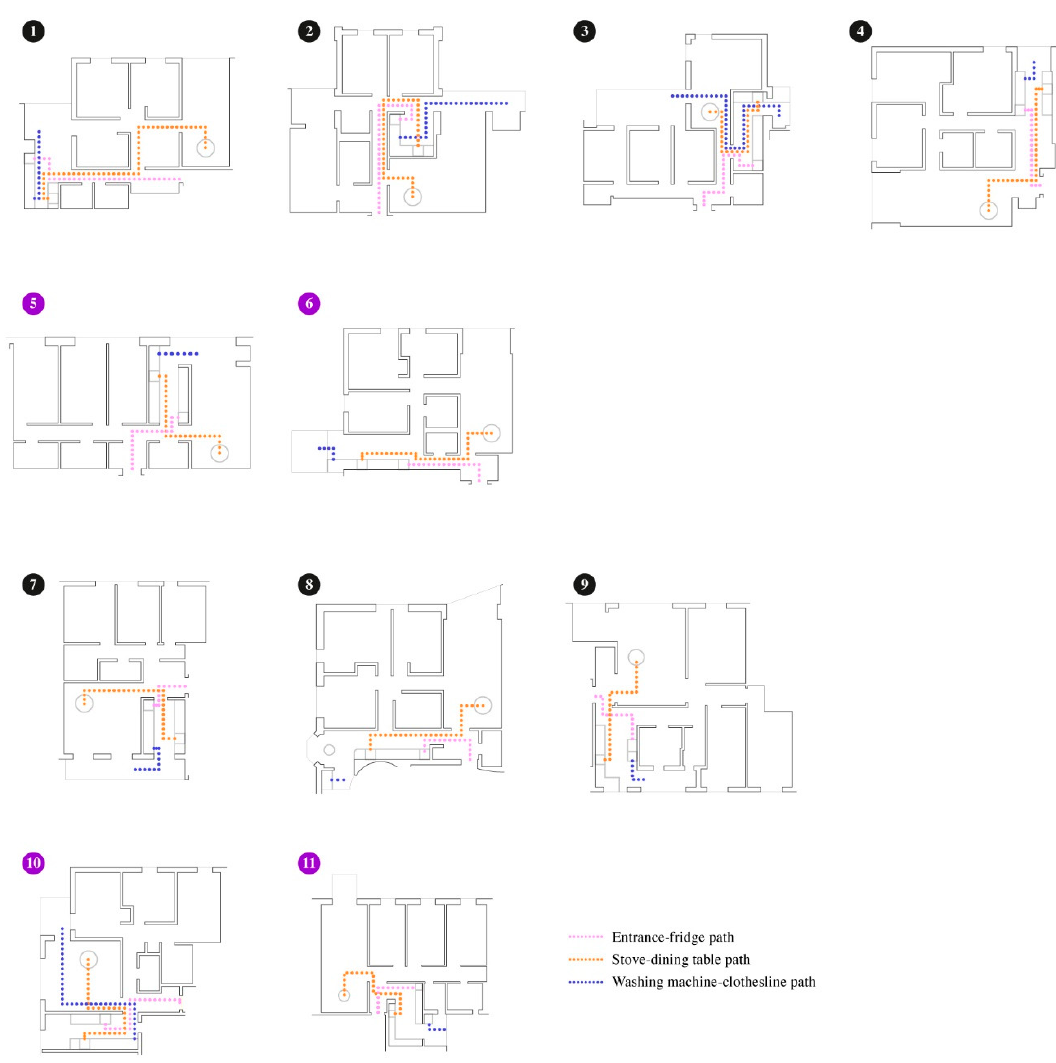
Figure 14. Apartment types: main reproduction task paths. Gender-inclusive teams numbered on purple circles (sub-figures are related to the numbered list of projects). Created by author.